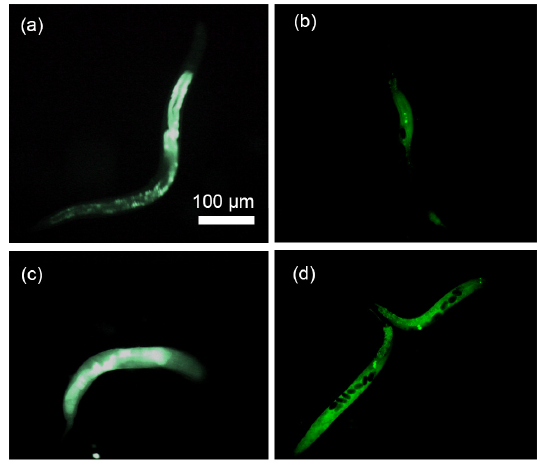
Figure 15. Fluorescent DNA solution was delivered into gonad ( a , b ) and the intestine ( c , d ) in both conventional ( right ) and microfluidic method ( left ). The scale bar shown in ( a ) is the same on ( b – d ).